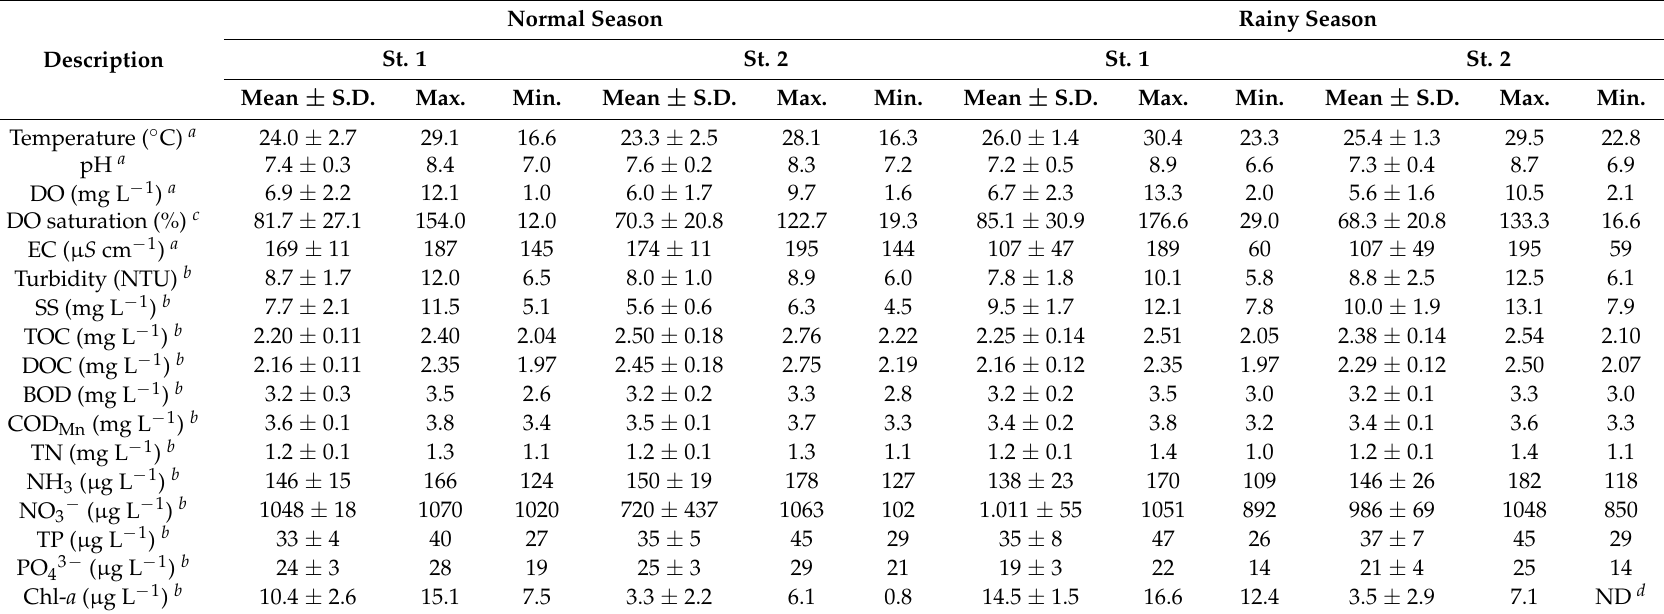
Table 2. Measurement data of the water quality parameters during normal and rainy seasons under the circulation conditions (2013).